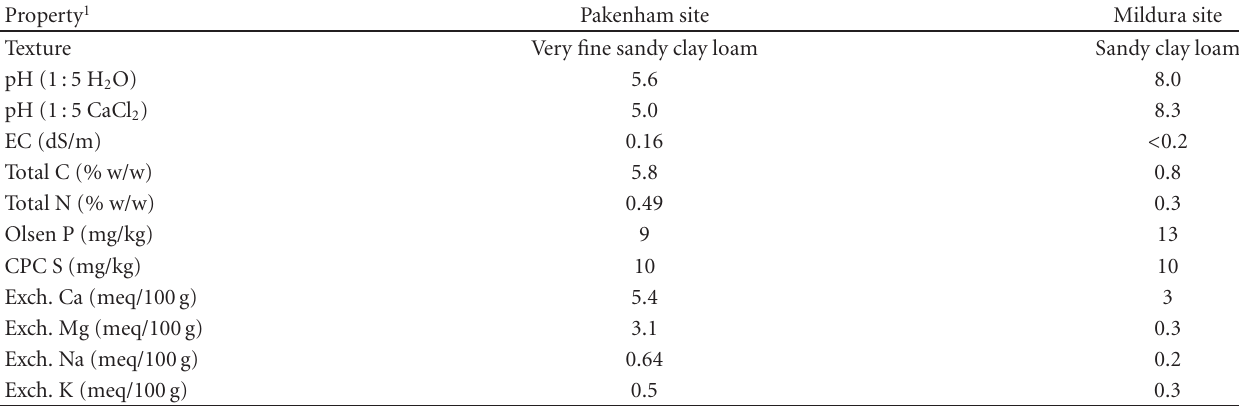
Table 1: Selected properties of surface soils (0–100mm) at Pakenham and Mildura prior to their use in the National Biosolids Research Program,